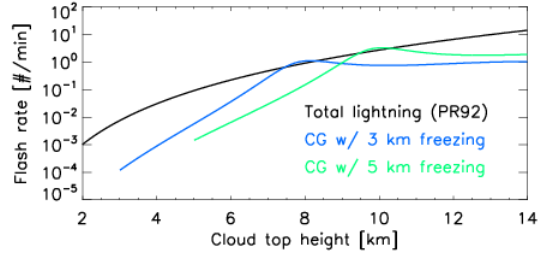
Fig. 7. Total lightning and CG flash rates computed using PR92 and PR93 for various cloud-top heights and freezing levels, demonstrating the source of spectral cut-off in Figure 6.